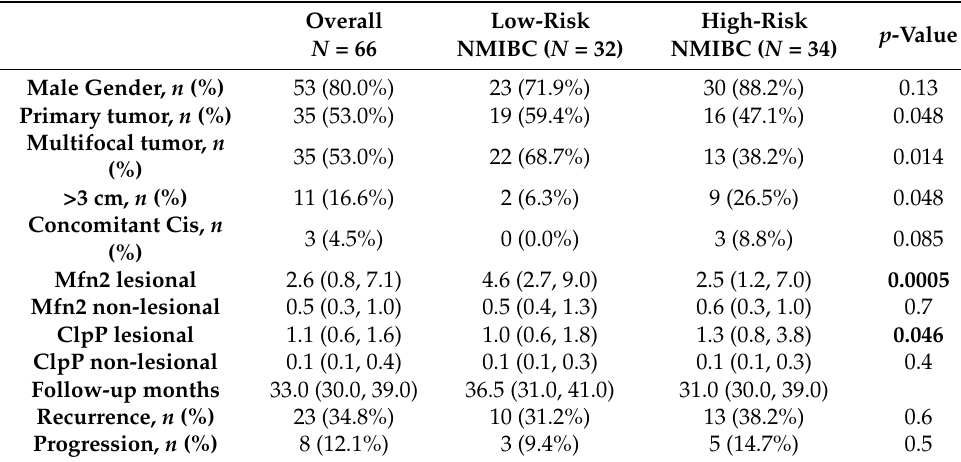
Table 1. Patients’